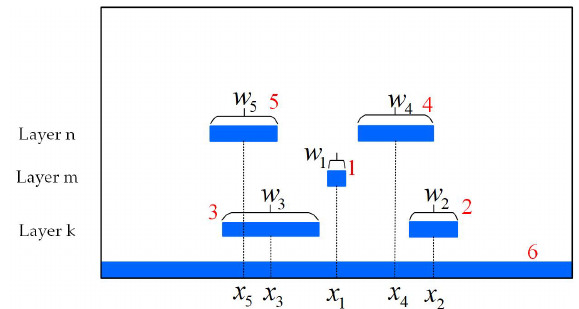
Figure 13. The illustration of pattern-2 and its geometry variables. Figure 13. T he illustration of pattern-2 and its geometry variables.